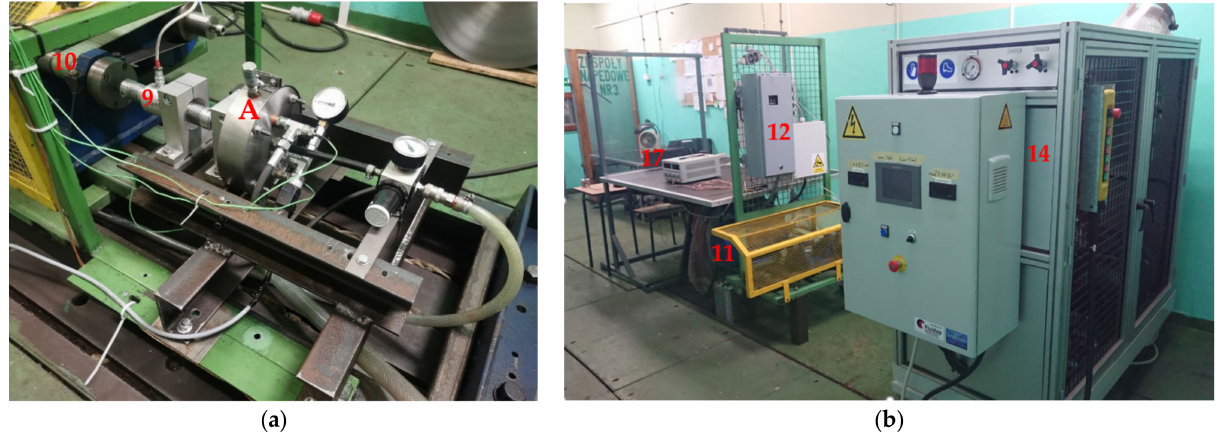
Figure 1. The scheme of the test rig: ( a ) test module; ( b ) general overview. Description in text above.